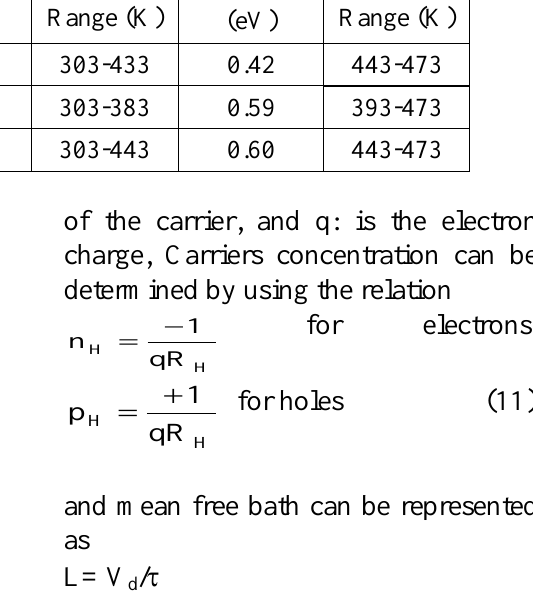
Temp. Temp. Range (K) (eV) Range